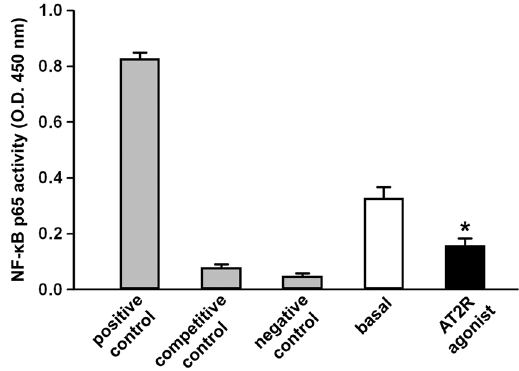
Figure 5. The angiotensin II type 2 receptor (AT2R) agonist CGP42112A reduces NF- κ B p65 DNA binding activity in rheumatoid arthritis fibroblast-like synoviocytes (RA-FLS). NF- κ B p65 DNA binding activity in RA-FLS at baseline and after treatment with AT2R agonist was determined by a NF- κ B EZ-TFA transcription factor assay colorimetric kit. Positive, competitive, and negative controls were carried out using TNF- α -treated Hela whole cell extract, unlabeled competitor oligonucleotide containing the identical consensus sequence as the capture probe in other samples, and without any capture probe, respectively. Bars represent the mean ± SEM of optical density (O.D.) measured at 450 nm. Results are representative of three independent experiments performed with each one of the six RA-FLS lines. Statistical analysis was carried out with Student’s t test; * p < 0.05 versus basal